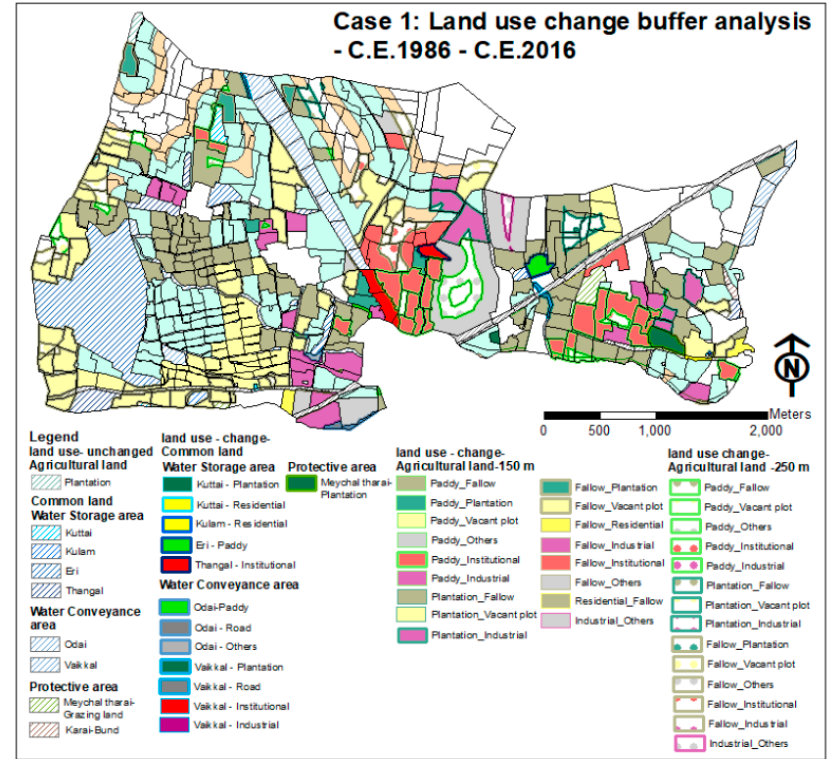
Figure A4. Output of buffer analysis—Case 1.